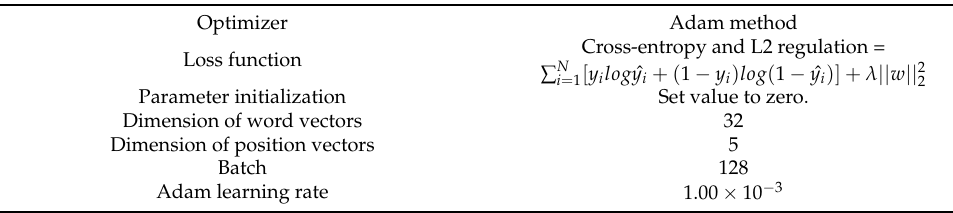
Table 7. Hyperparameter Settings.